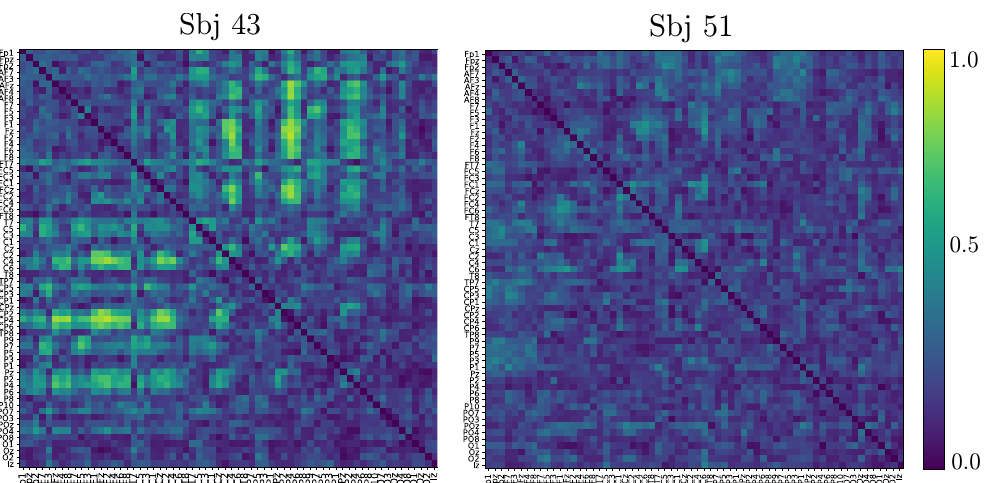
Figure 7. Connectivity matrix after two-sample Kolmogorov-Smirnov test obtained by the best ( left side ) and poorest-performing ( right side ) subjects. The pictured GFC matrices include both MI tasks and are computed at 90-percentile of normalized relevance